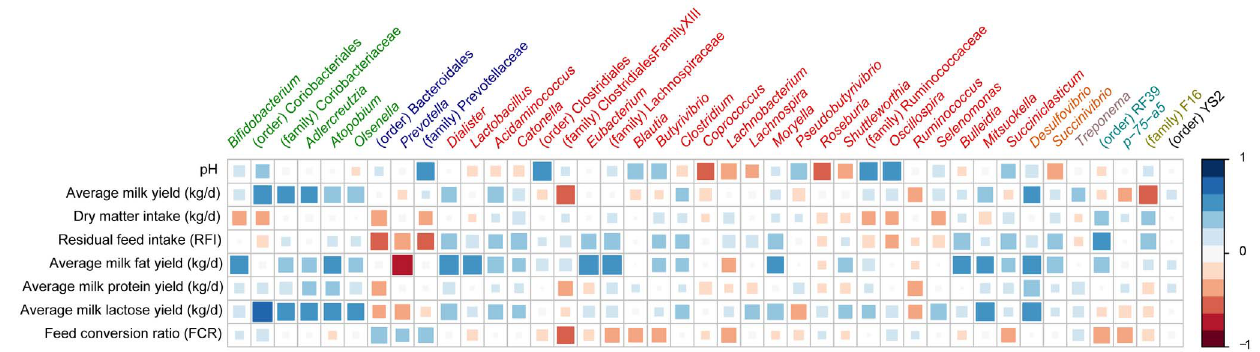
Figure 3. Correlation between efficiency parameter and genus abundance. Pearson linear correlation matrix of the dominant bacterial genera across the rumen samples. The genera were included in the matrix if they were in at least 50% of the cows and represented at least 0.1% of the bacterial community in at least one of the cows. Strong correlations are indicated by large squares, weak correlations by small squares. The scale colors denote whether the correlation is positive (closer to 1, blue squares) or negative (closer to 2 1, red squares) between the genera and the efficiency parameters. Color coding represents the phylum to which each genus belongs, as follows: Actinobacteria (green), Bacteroidetes (blue), Firmicutes (red), Proteobacteria (orange), Spirochaetes (purple), Tenericutes (light blue), TM7 (olive), Cyanobacteria (black).